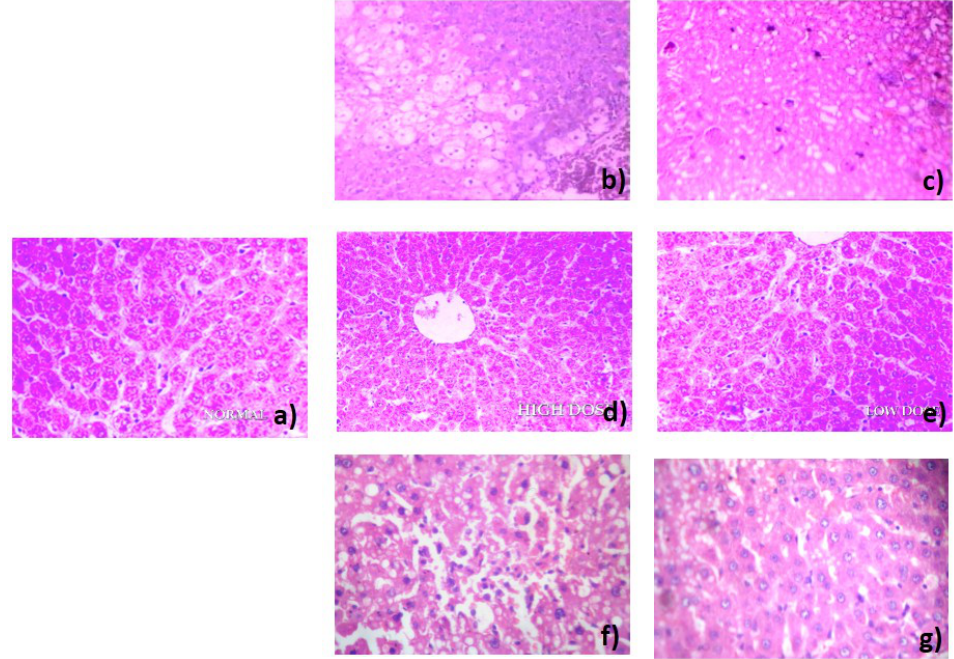
Figure 3. Histology of liver stained with hematoxylin-eosin (×100) of the groups of mice. ( a ) Normal; ( b ) CCl -intoxicated; ( c ) CCl + silymarin treated; ( d ) CCl + HMF 4 4 4 (200 mg/kg b.w.); ( e ) CCl + HMF (100 mg/kg b.w.); ( f ) CCl + HML (200 mg/kg b.w.); 4 4 ( g ) CCl + HML (100 mg/kg 4